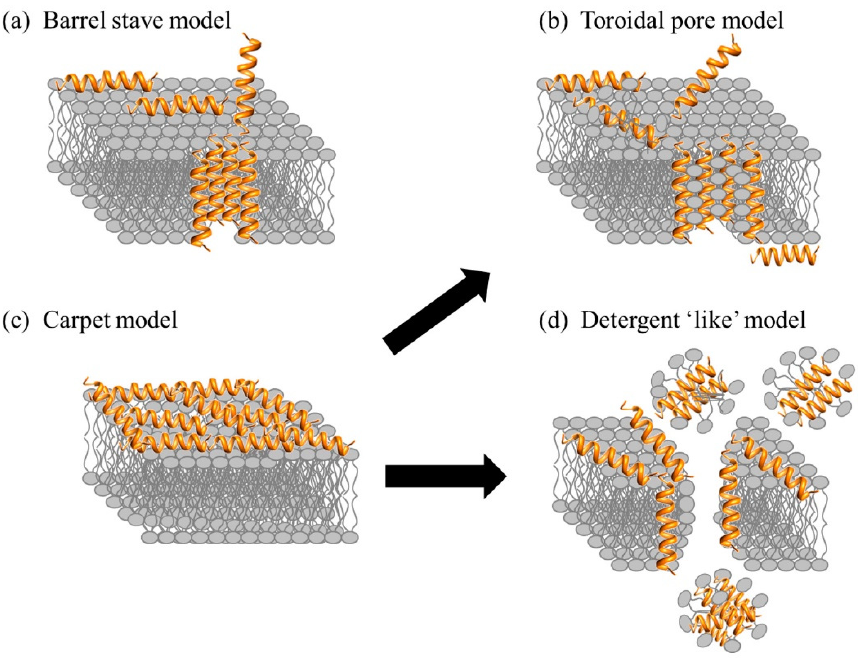
Figure 4. Bacterial cell membrane disruption by AMPs through four common mechanisms. Repro-